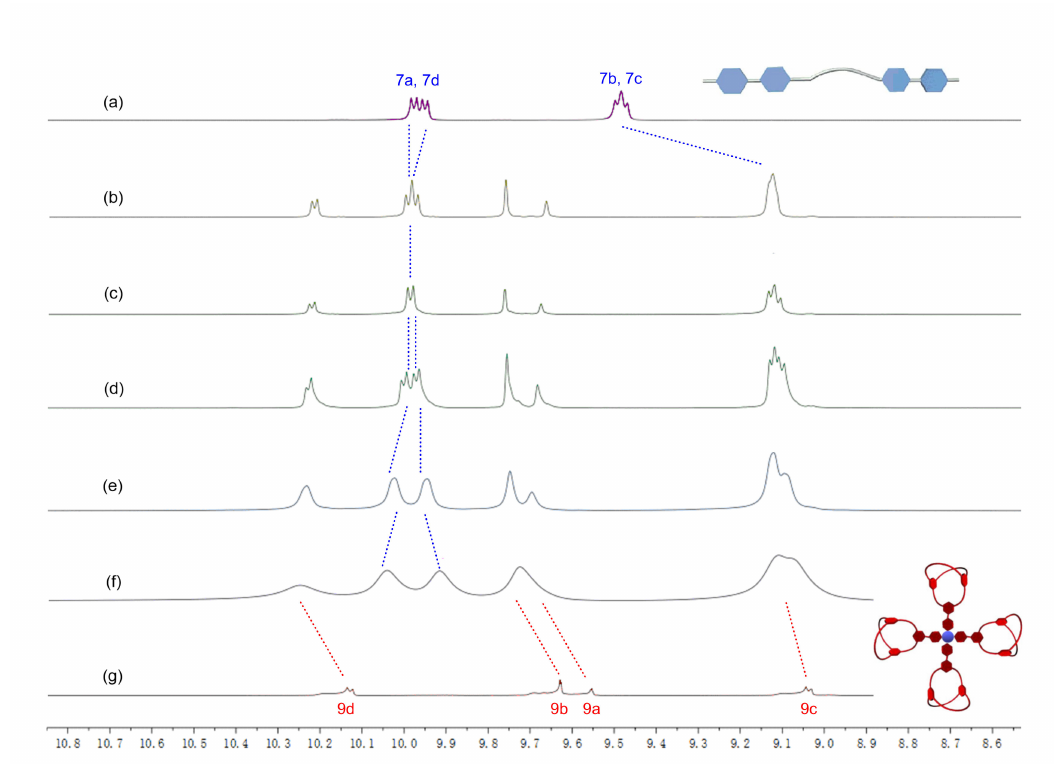
Figure 6. Partial 1 H NMR spectra [500 MHz, CD 2 Cl 2 /CD 3 NO 2 (1:1, v / v ), 298 K]: ( a ) 7 ; (b–g) solutions of 7 and 9 with 2:1 molar ratio at concentrations of ( b ) 2.50 mM, ( c ) 5.00 mM, ( d ) 10.0 mM, ( e ) 25.0 mM, ( f ) 100.0 mM; ( g ) 9 . The assignments of protons were shown in Scheme